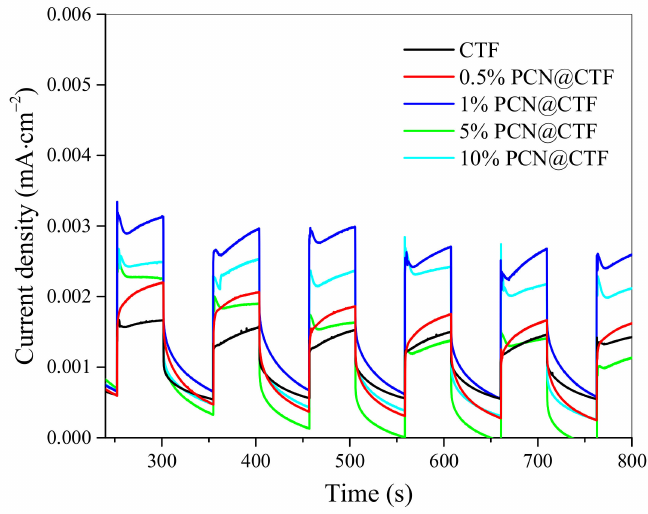
Figure 8. Periodic ON/OFF photocurrent responses of CTF and x